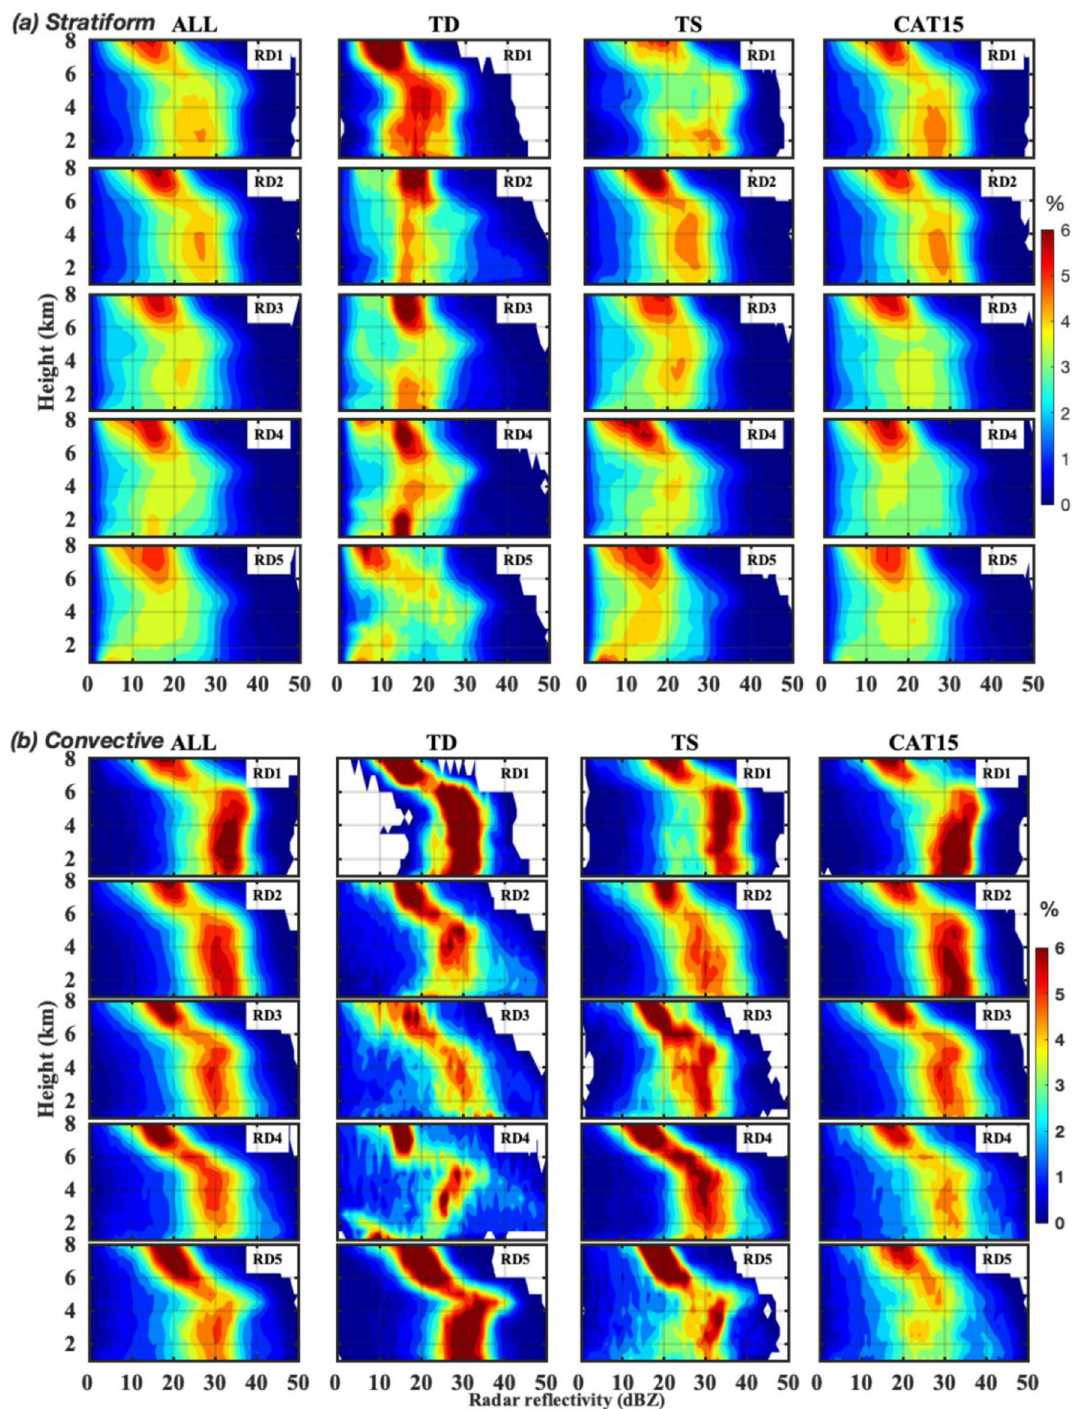
Figure 4. Echo profiles of different category TCs at different radial distances for stratiform and convective precipitation. Same as Fig. 3 but for ( a ) stratiform and ( b ) convective